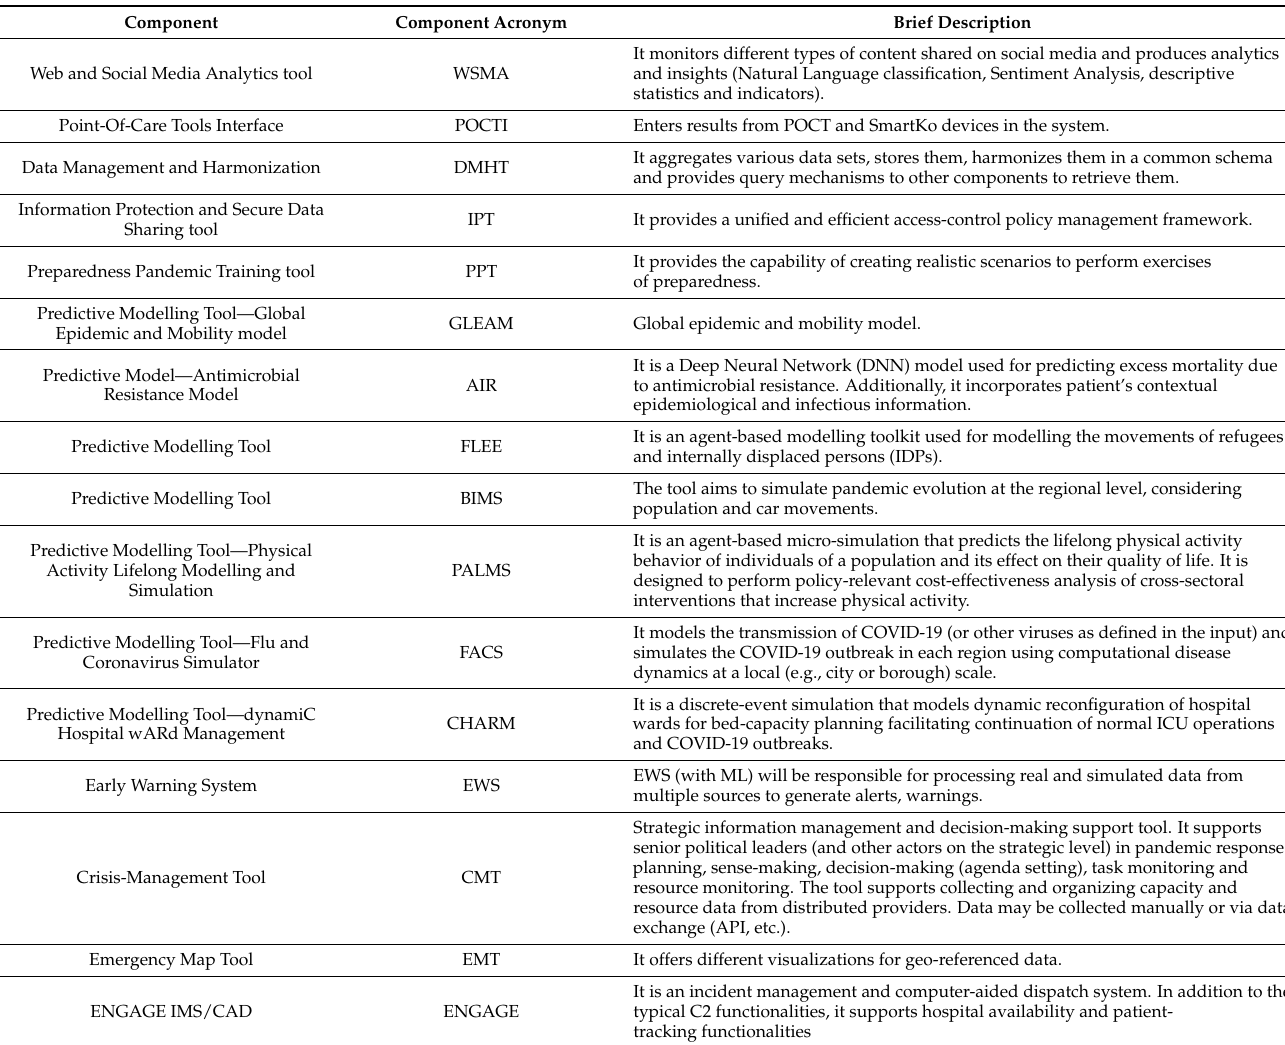
Table 1. STAMINA Platform List of